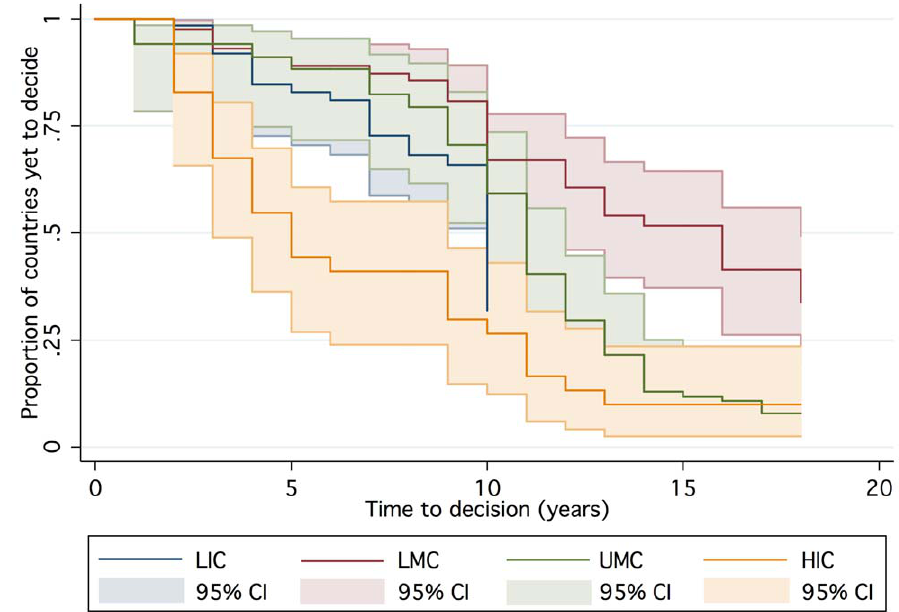
Figure 2. Time to decision by World Bank income group. See [17].